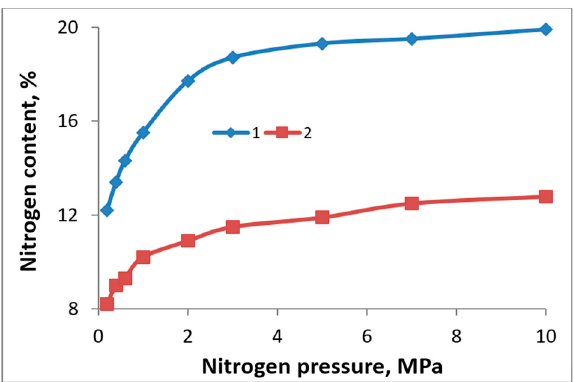
Figure 7. The impact of nitrogen pressure on the extent of chromium nitridation. 1—slowly cooling down samples and 2—quenched samples.